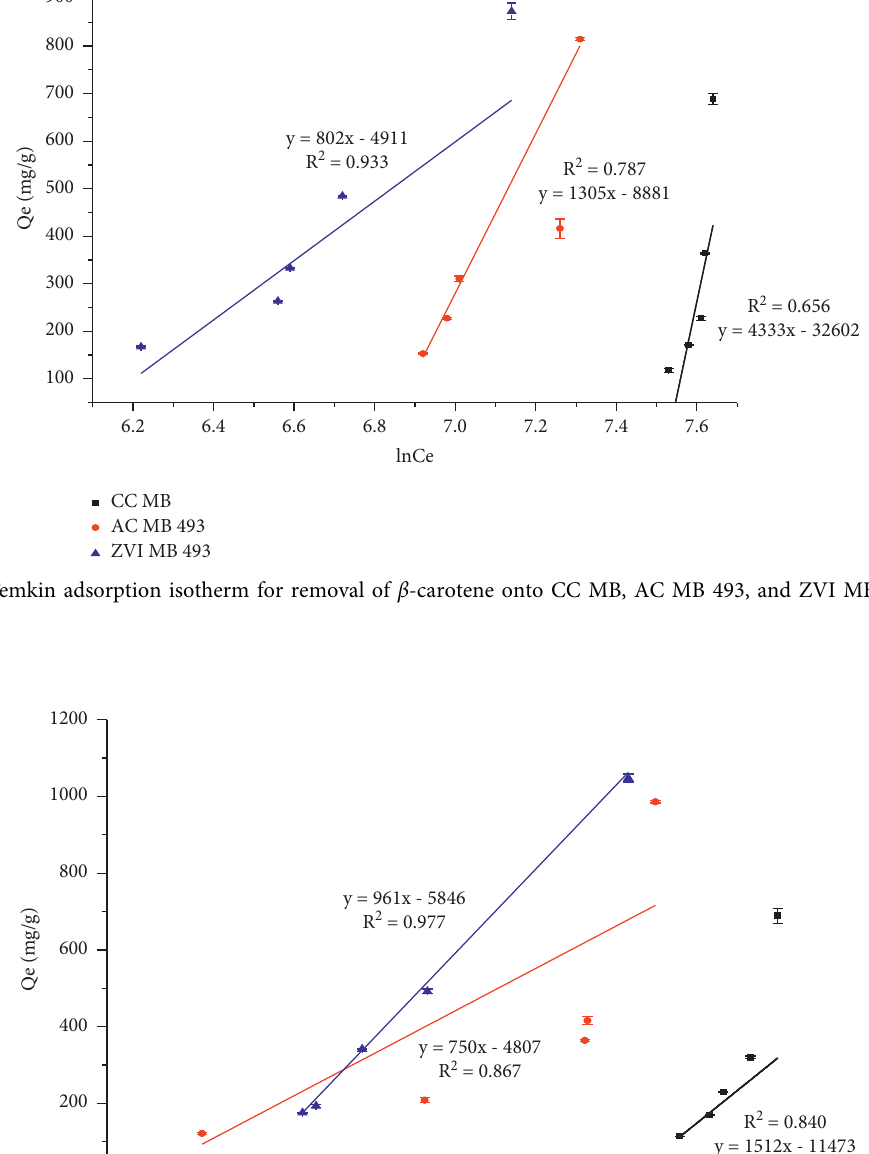
y = 961x - 5846 R 2 = 0.977